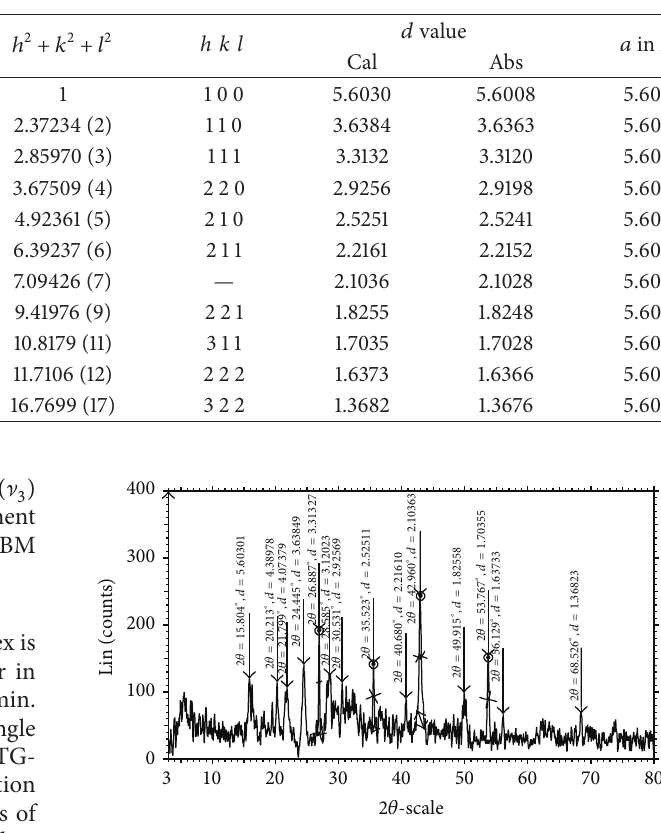
Figure 2: Powder XRD pattern of Cu(II)